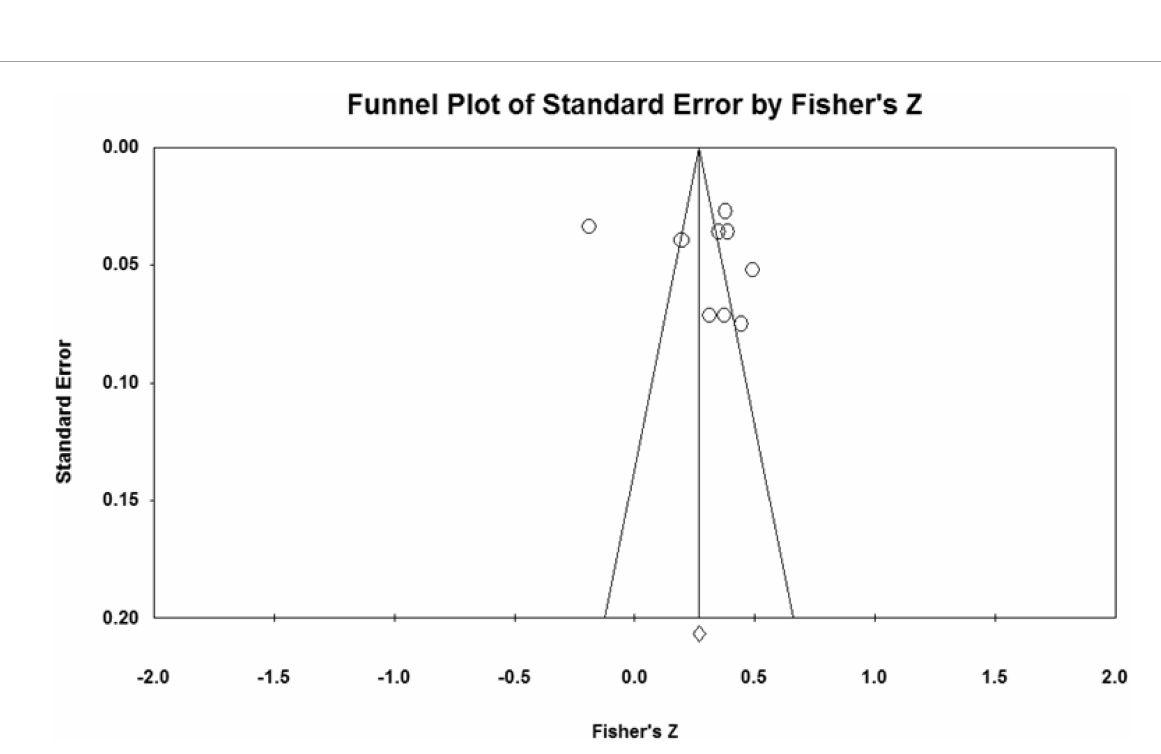
FIGURE4 Funnel plot of the relationship between indulgent parenting and sibling conflicts